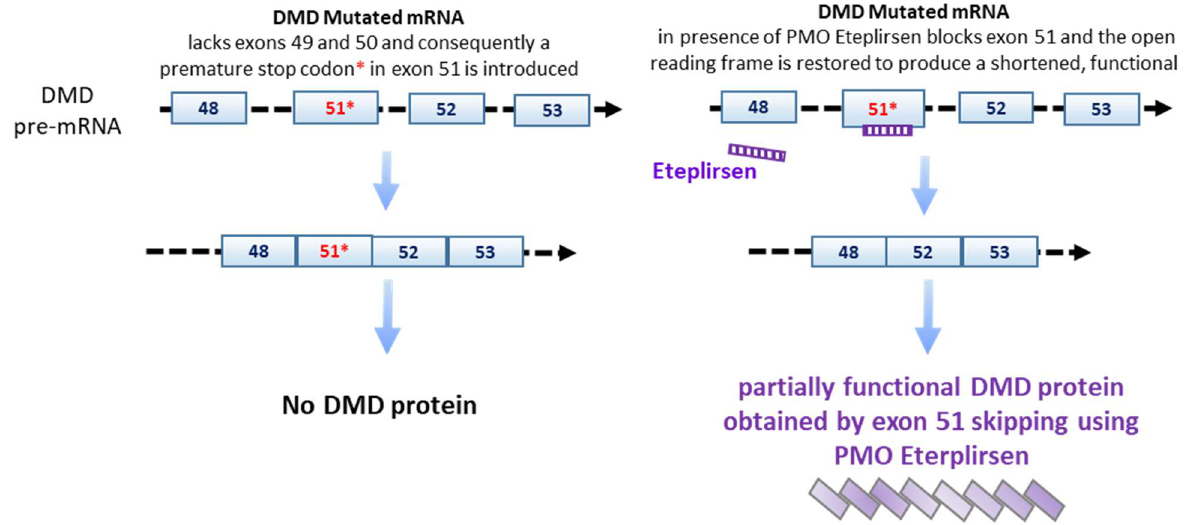
Figure 3. mRNA/ASO–Fomivirsen interaction prevents RNA loading in ribosome and blocks mRNA translation into protein IE2 in the cytoplasm. A detailed description is reported in the text.